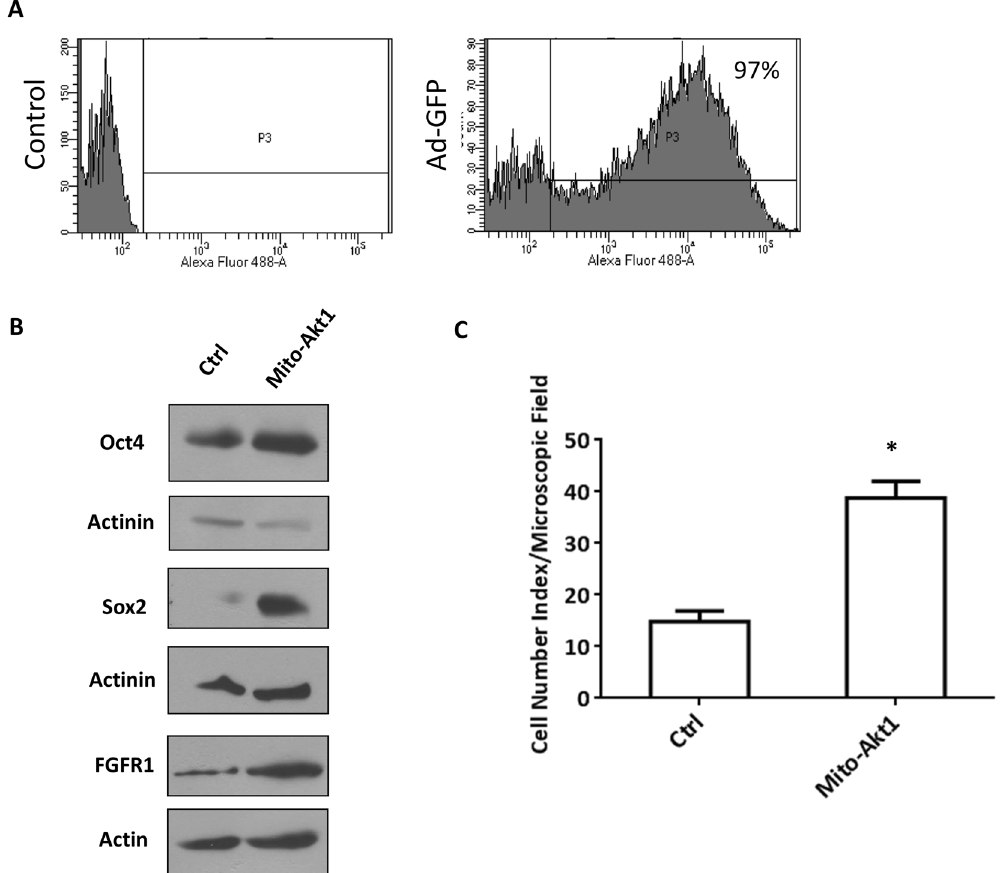
Figure 6. The effect of mitochondrial Akt in human embryonic stem cells. ( A ) Transduction efficiency of adenoviral vector in H9 cells. H9 cells were transduced with Ad-GFP (control) for 72 h. After viral transduction, the cells were washed and analyzed with FACS. 97% of cells were positive for GFP expression. ( B ) Mitochondrial Akt1 enhanced stem cell pluripotency marker expression in hESC. H9 cells were transduced with Mito-Akt1 or Ad-GFP (control) in hES media without bFGF for 72 hours. Protein lysates were resolved with SDS-PAGE and immunoblotted with specific antibodies. The abundance of Oct4, Sox2, and FGFR1 was increased in the cells transduced with Mito-Akt1 (full size western blot image in Supplementary Information), actinin and actin served as loading control. ( C ) Activation of mitochondrial Akt1 increased cell proliferation in hESC. H9 cells were transduced with Mito-Akt1 or control virus for 65 hours and the cell number per microscopic field was counted in 10 random fields on each plate. The bar graph represents the results from 4 independent experiments in triplicates. * P <